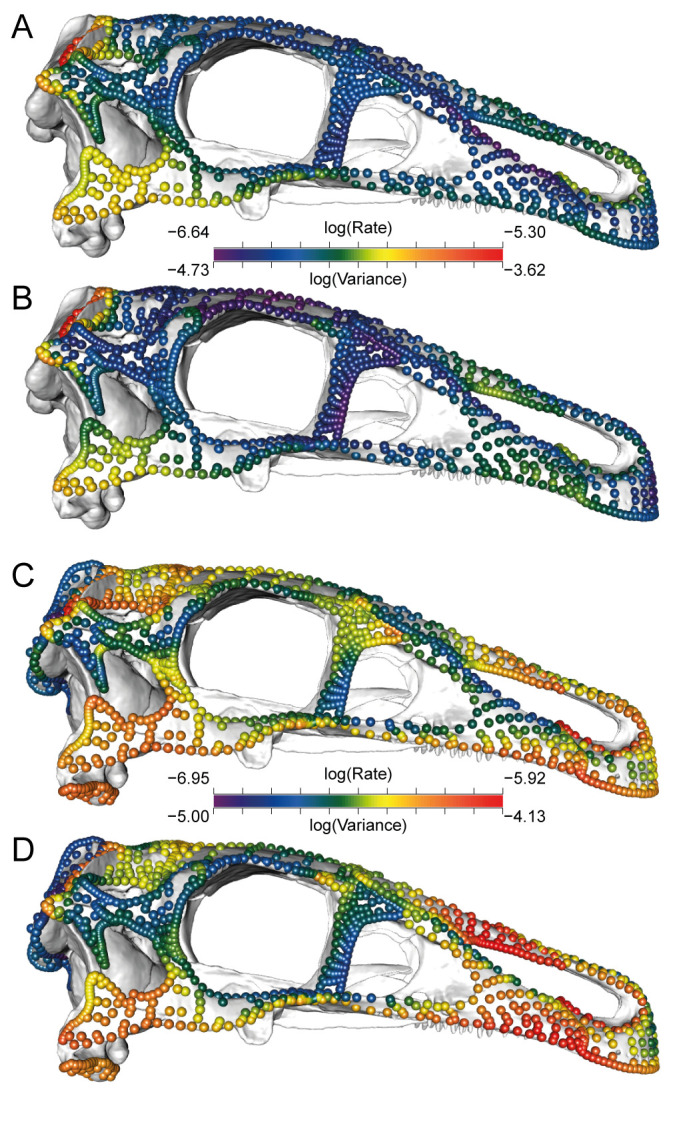
Per-landmark evolutionary rates (under single-rate BM model) and Procrustes variance.Landmarks and sliding semi-landmarks represented in the 9-module dataset (A, B) and 11-module dataset (C, D), illustrated on the skull of Erlikosaurus andrewsi (IGM 100/111). Landmarks are coloured according to evolutionary rate (A, C) and Procrustes variance (B, D), where a warmer colour indicates greater value. Data and code archived at www.github.com/rnfelice/Dinosaur_Skulls. BM, Brownian Motion; IGM, Paleontological Center, Mongolian Academy of Sciences.